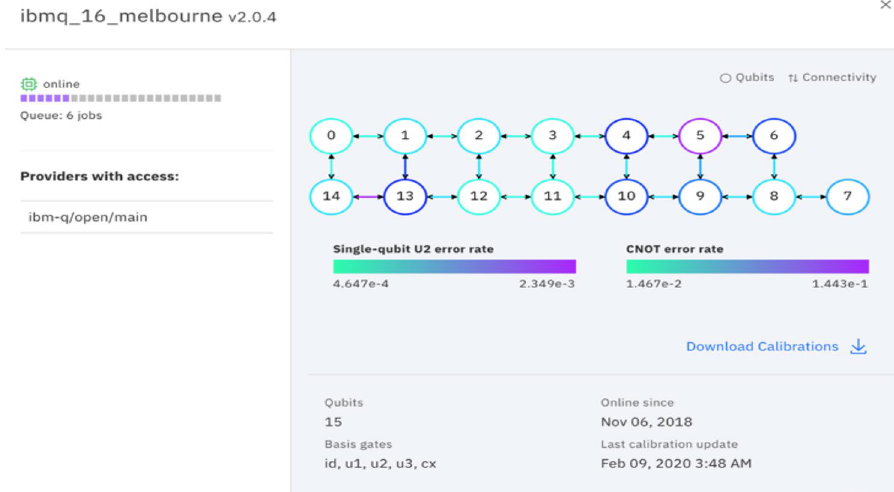
Figure 8. A diagram of single- and multi-qubit error rates in ibmq_16_melbourne, provided by